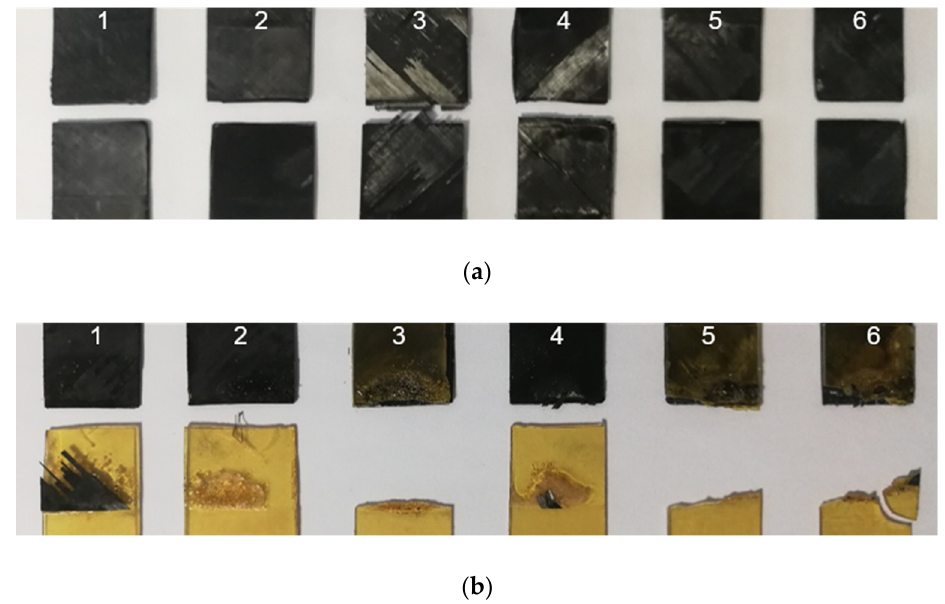
Figure 15. Fracture surface after LSS testing of induction welded specimens from 1 to 6 for ( a ) CF/PEEK on CF/PEEK and ( b ) 1 mm thick PEI on CF/PEEK.